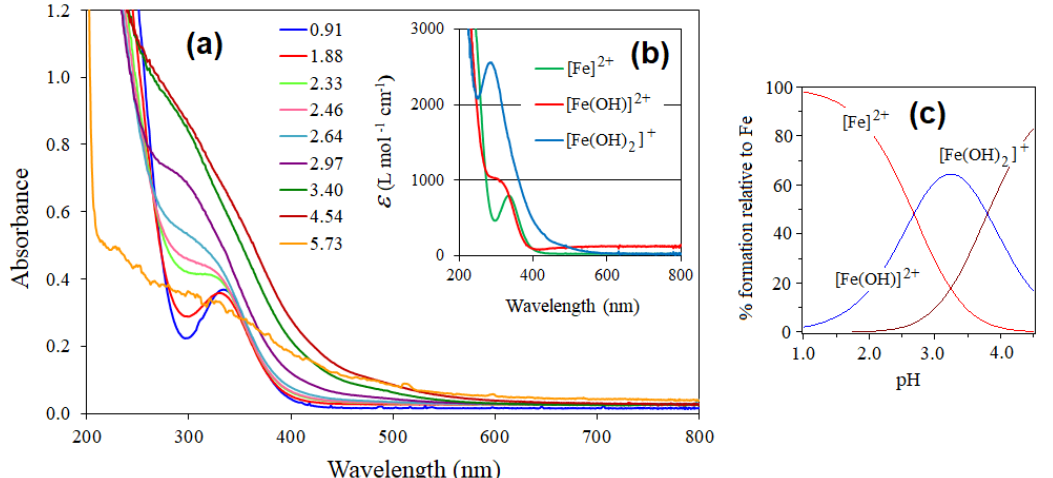
Fig. S1. (a) UV-Vis spectra of iron(III) chloride within the pH range 0.91 – 5.73, C FeCl = 5.0 × 10 -4 mol L -1 . (b) Molar absorption coefficients for various Fe(III) aqua-hydroxo complexes. (c) Species distribution curves as a function of pH for the Fe(III) aqua- hydroxo